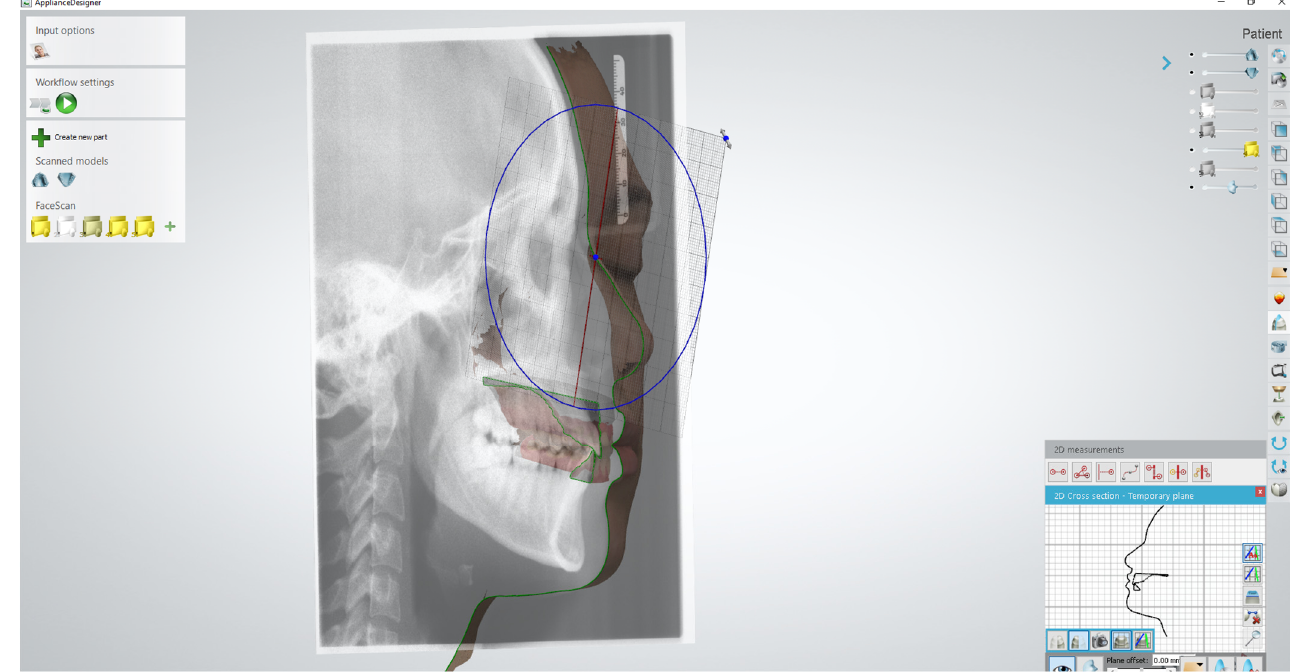
Figure 8. Upper arch is removed from face scan with the smile.